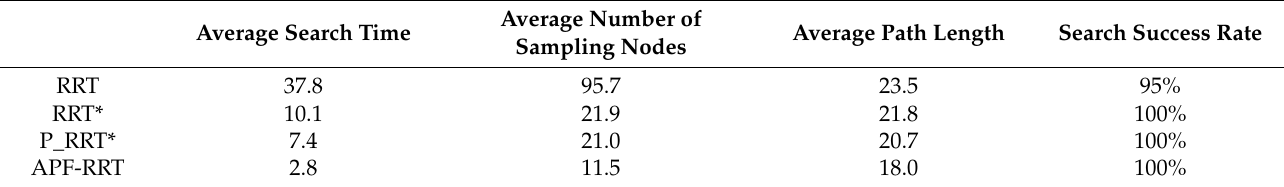
Table 3. Comparison of various algorithms under the same